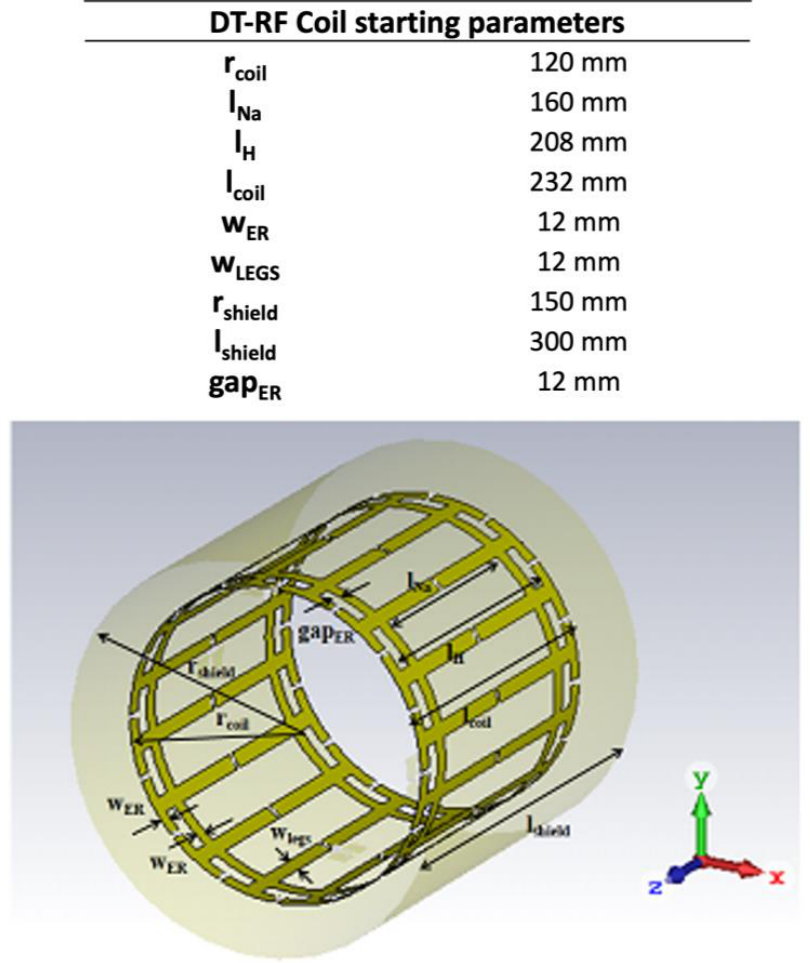
Figure 2. EM CAD model and starting dimensions of the four-ring DT-RF birdcage coil with sixteen legs.